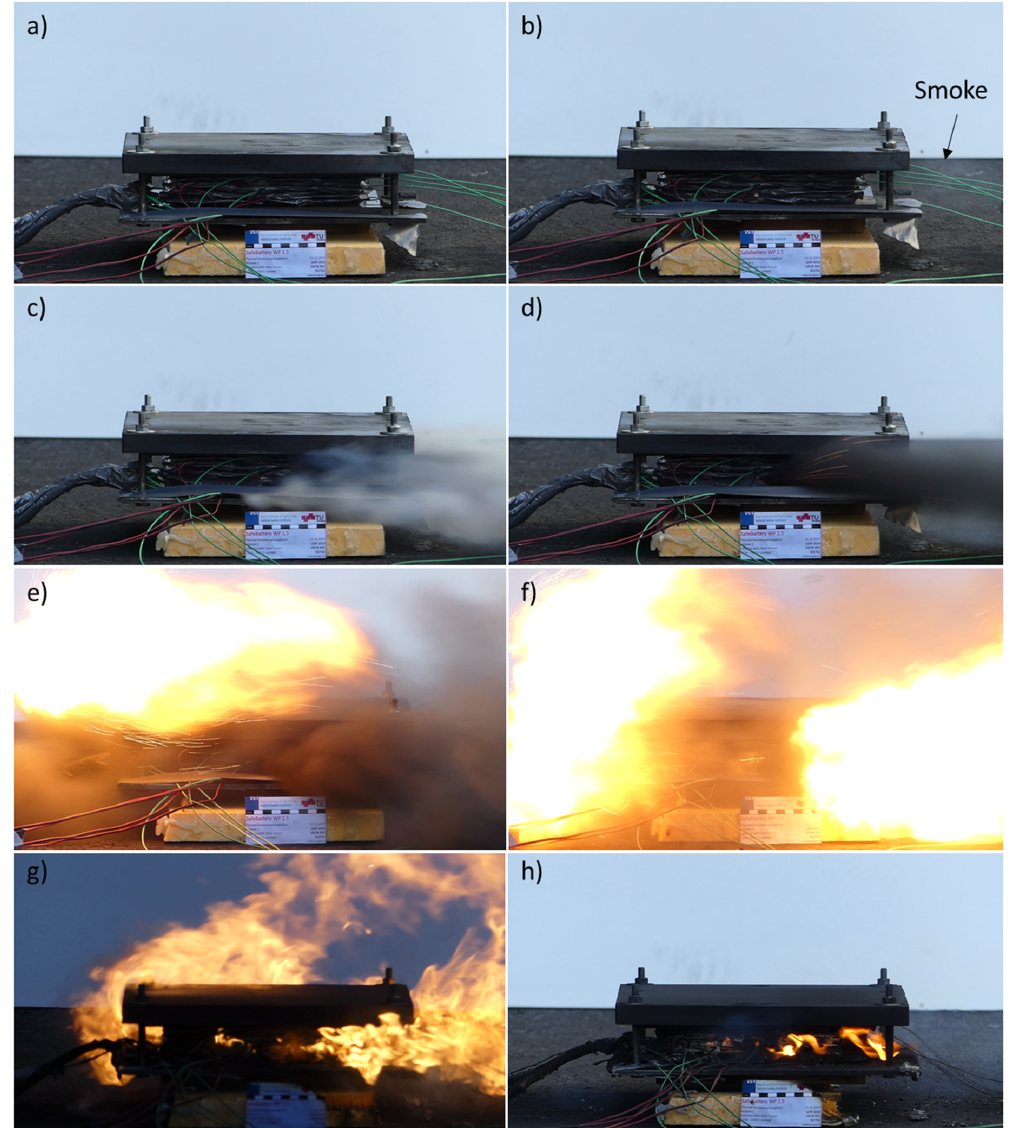
Figure 6. Description of the TR phases observed and recorded with a high-definition camera: ( a ) initial warm up phase, no observable effects; ( b ) slight smoke detected, probably due to electrolyte evaporation through sealing; ( c ) gas venting, sparks and embers are not yet present, smoke is mainly of white color; ( d ) gas venting with increased speed, gas has a darker color, sparkles and embers occur; ( e ) due to sparkles and embers, vented gas initiate combustion; ( f ) deep TR and combustion of vented gases; ( g ) system starts to cool down, uncombusted active materials are still present and burning slowly; ( h ) active materials are all combusted, system cools down.